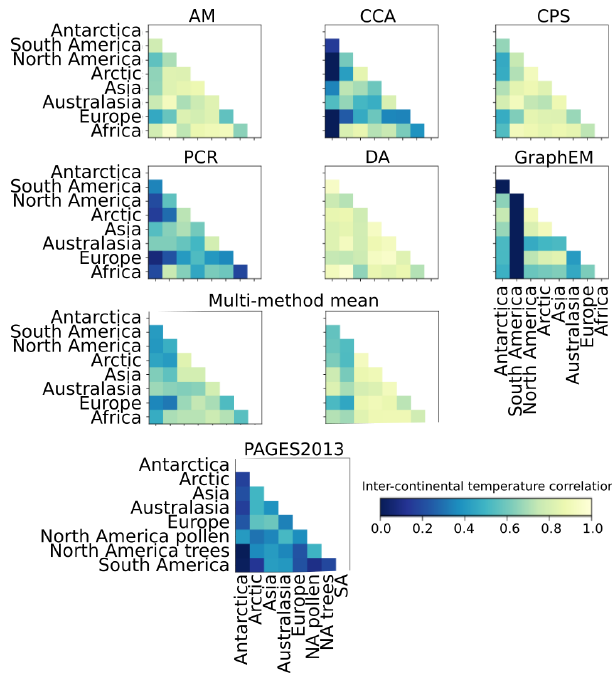
Figure 6. Reconstruction-based inter-regional temperature corre- lations. Shown are the PAGES-2k results for the individual CFR methods (Neukom et al., 2019), two different ways to calculate the multi-method and multi-ensemble mean, and the results based on the original PAGES-2k temperature time series (Ahmed et al., 2013). The top six panels show the results in which individual inter- regional temperature correlations are calculated for every ensemble member, after which the results are averaged for a single CFR. The multi-method mean of those results is shown on the left panel in the third row. Another method is to calculate ensemble mean tem- perature time series for every grid cell, then regional averages and finally inter-regional temperature correlations. The corresponding multi-method mean is shown here in the right panel in the third row, while the corresponding results for the individual CFRs are shown in Fig. A4. Note that these results are non-lagged correlations and that partially different continental-scale regions are shown for the results based on the original PAGES-2k temperature time